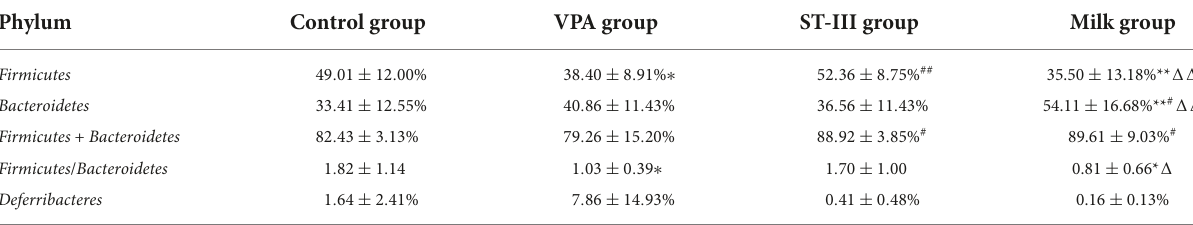
TABLE 1 Relative abundance of gut microbiota and F/B ratio in the control, VPA, ST-III and milk group at the level of phylum.